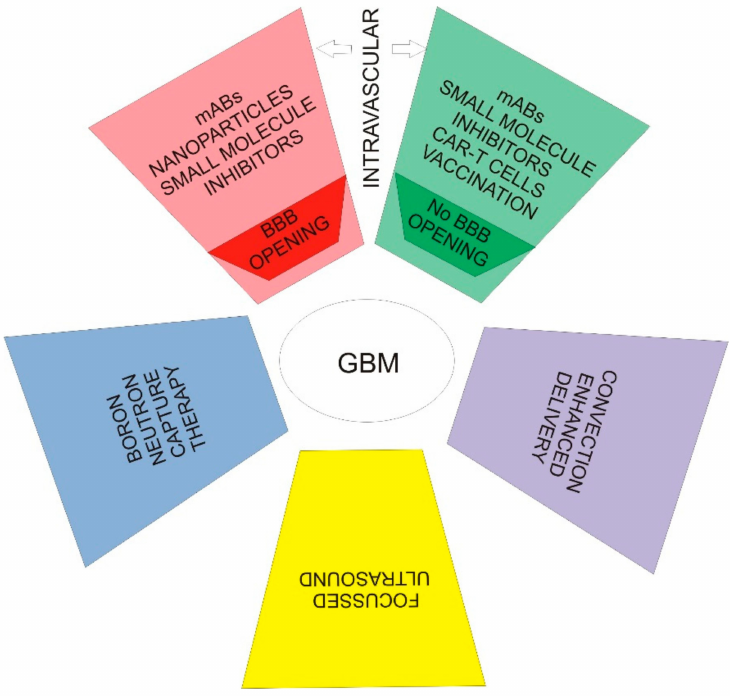
Figure 2. EGFR-based therapies in glioblastoma. (BBB—blood brain barrier, mABs—monoclonal antibodies, CAR-T—Chimeric anti-gen receptor T cell therapy) Erlotinib (Tarceva, OSI-774) proved to prolong NSCLC patients’ survival rate